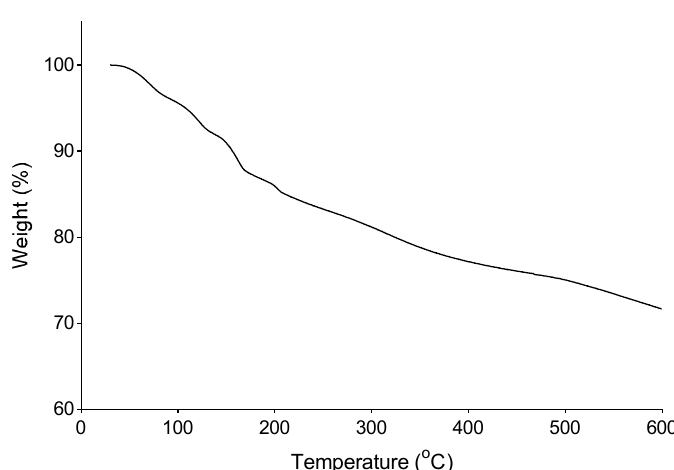
Figure 9. Thermo-gravimetric analysis of the bioflocculant.